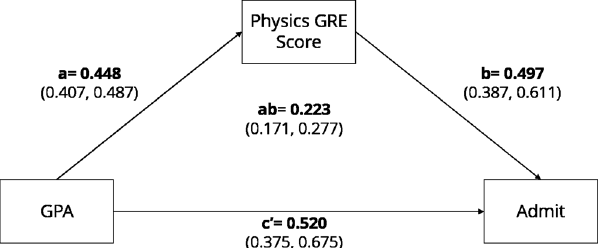
FIG. 9. Visual representation of the bootstrapped coefficients in Eqs. (1) to (3). We do find evidence of the physics GRE score mediating the relationship between GPA and admission status.